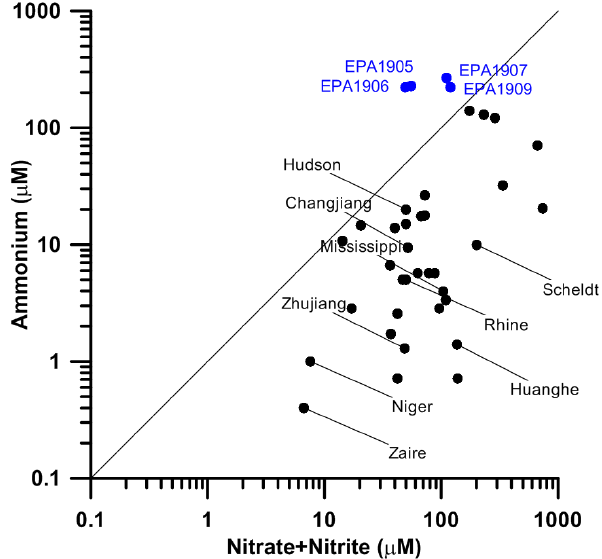
Figure 9. Ammonium concentration plotted against nitrate + nitrite concentration. The blue circles are the sites in/near the Danshui es- tuary, and the black circles are from documented large rivers. The 1 : 1 line is